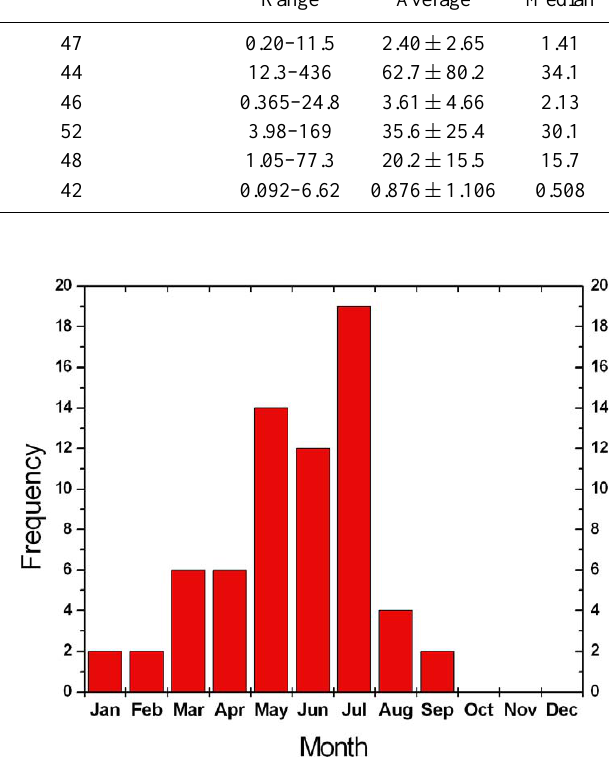
Fig. 1. Seasonal frequency of PE Fig. 1: Seasonal frequency of PE occurrence.